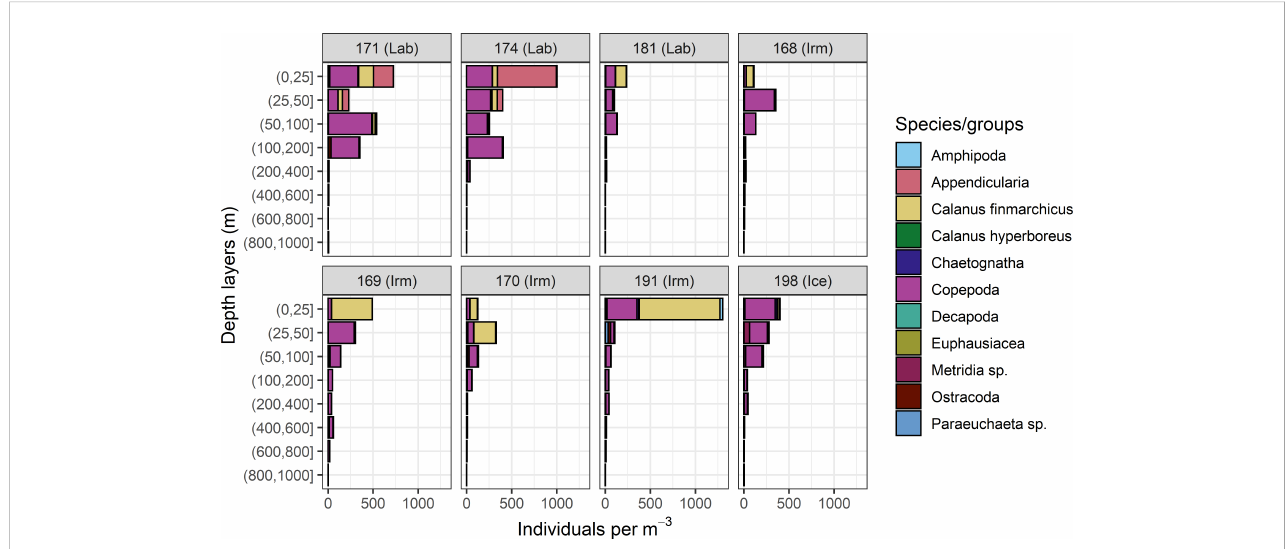
FIGURE 10 The composition of zooplankton taxonomic groups from MOCNESS hauls used for the Ivlev electivity index calculations. The data are grouped using the same categories as those obtained for the stomach contents. Each panel show the basins and the associated CTD station number where the sample was obtained. St 168-171 show data from the westward leg, while st174-198 are data from the eastward return to Norway (see Drinkwater et al.,